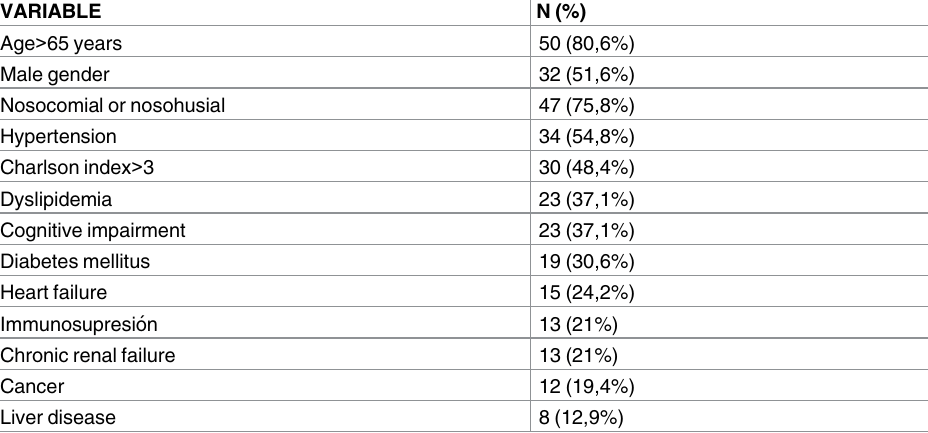
Table 1. Baseline characteristics of